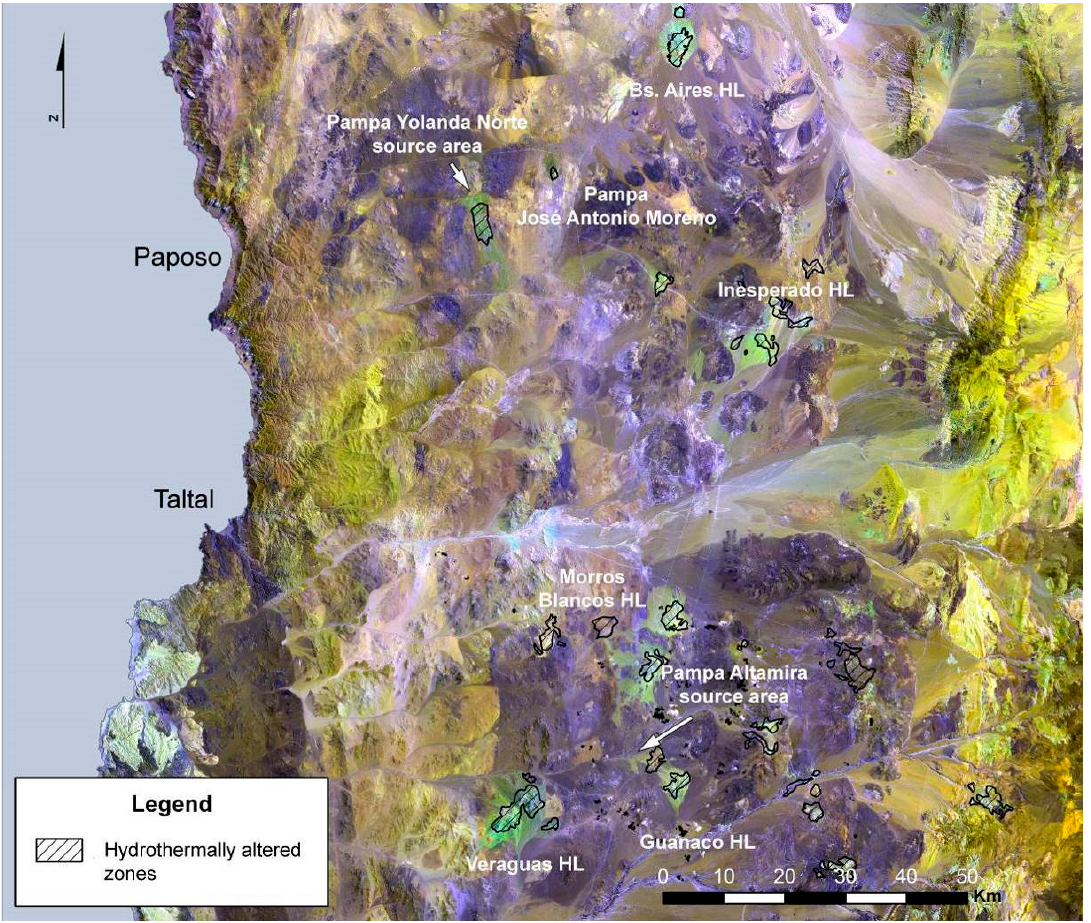
Figure 4. Landsat 8, bands 7-6-2 (RGB) false-color composite. Potential and actual chert source areas are highlighted in light green, and hydrothermally-altered zones are shown as black hatched polygons.